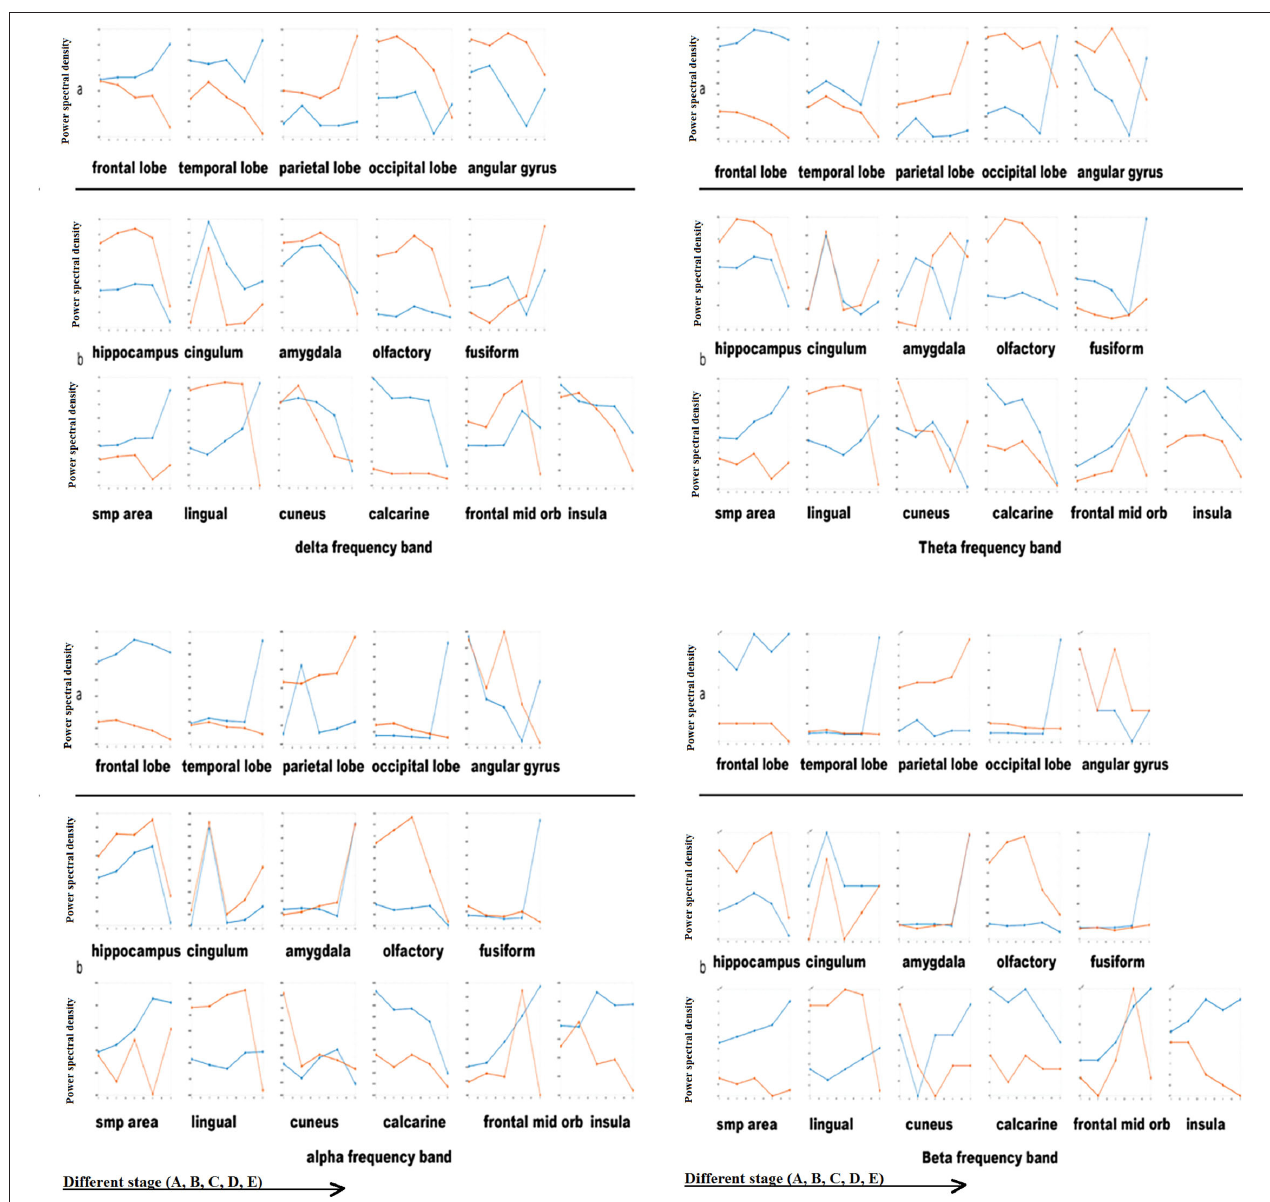
FIGURE 4 | Power spectral density of cortical and deep areas. *Blue line: left hemisphere; red line: right hemisphere. X-axis: different stage (A, B, C, D, E); Y-axis: Power spectral density [Magnitude (signal units/sqrt(Hz))*10 − 4